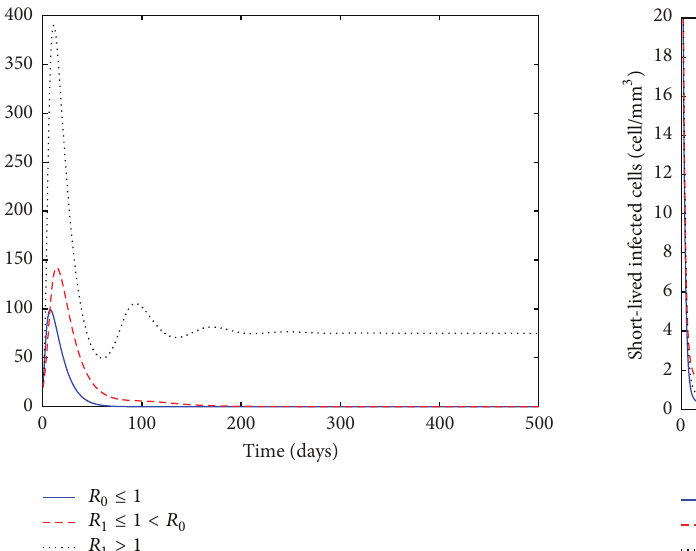
Figure 7: The evolution of short-lived infected cells for model (33)– (37).